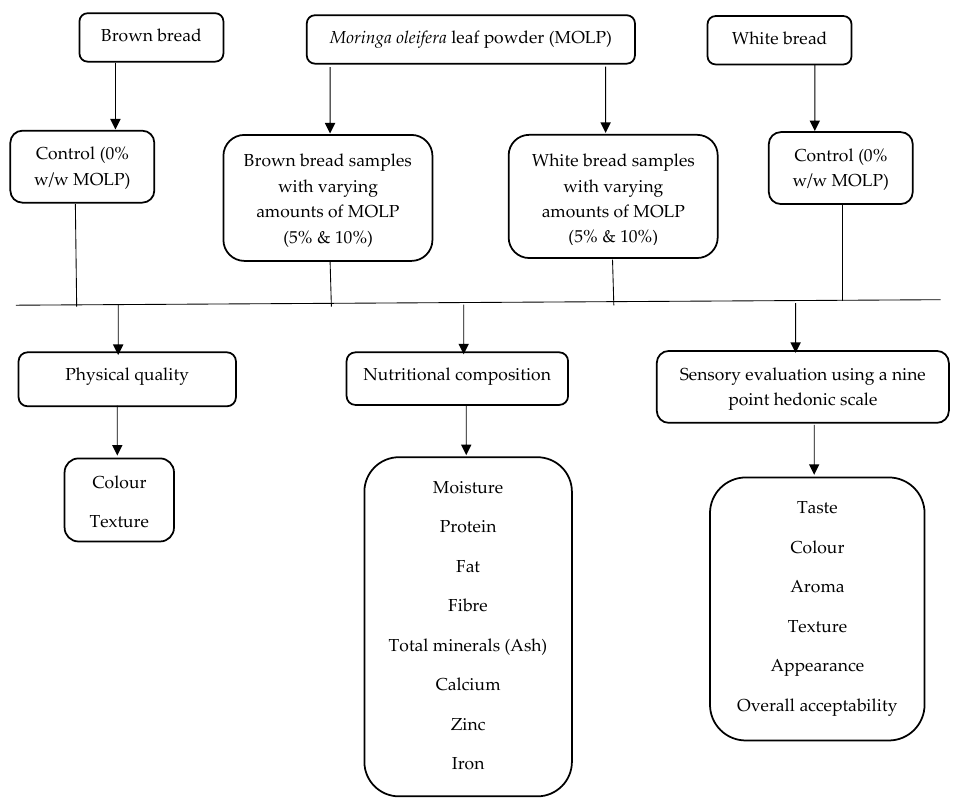
Figure 1. Conceptual framework of the